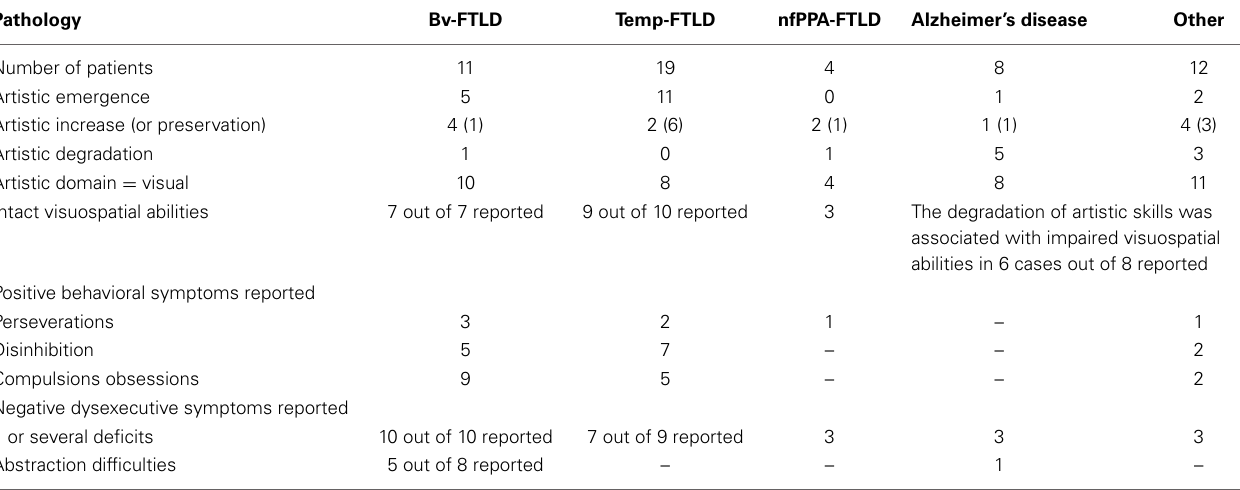
Table 2 | Synthesis of cognitive, behavioral and artistic changes in previous published cases of patients listed in Table 1 and in our patient.